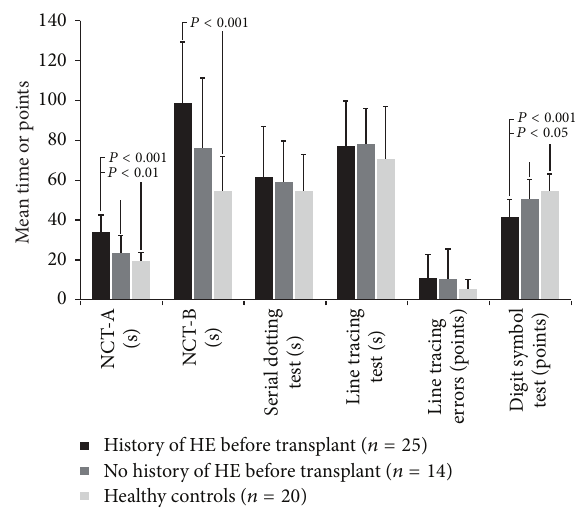
Figure 1: Psychometric HE score results for patients with a history of HE before transplant compared with patients with no history of HE before transplant and age-matched healthy individuals. HE, hepatic encephalopathy; NCT-A, number connection test A; NCT- B, number connection test B. Adapted with permission from Sotil et al., Copyright © 2009 American Association for the Study of Liver Diseases